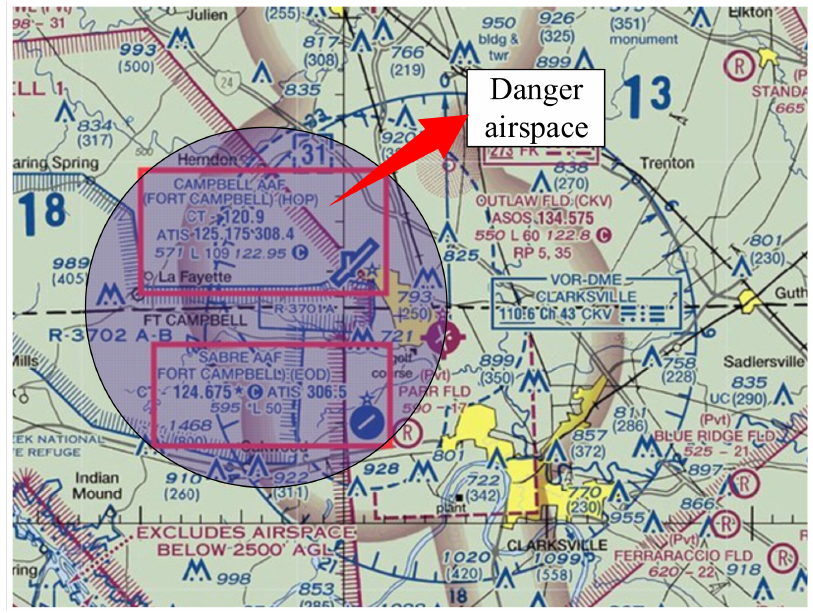
Figure 3. Example of dangerous